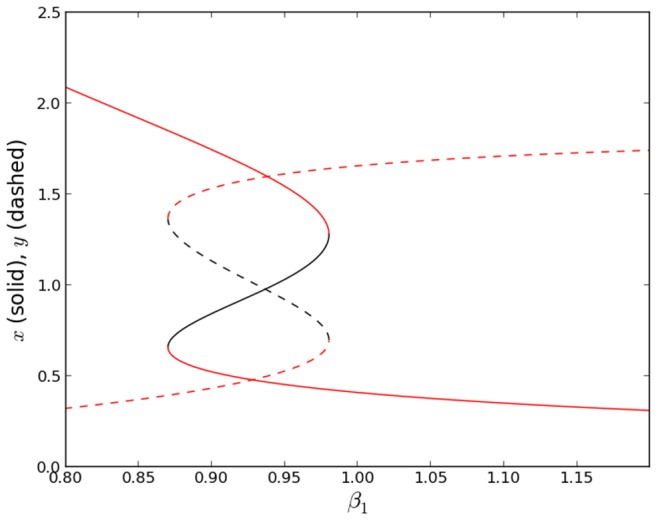
Bifurcation diagram for state-variables  (solid) and  (dashed) configured for OR/NOR.
 and  are complementary outputs, when one is high the other is low. Red (black) indicate stable (unstable) fixed points. System is bistable for . Calculated for Eqs. (2)–(3) with , , , , , , and .